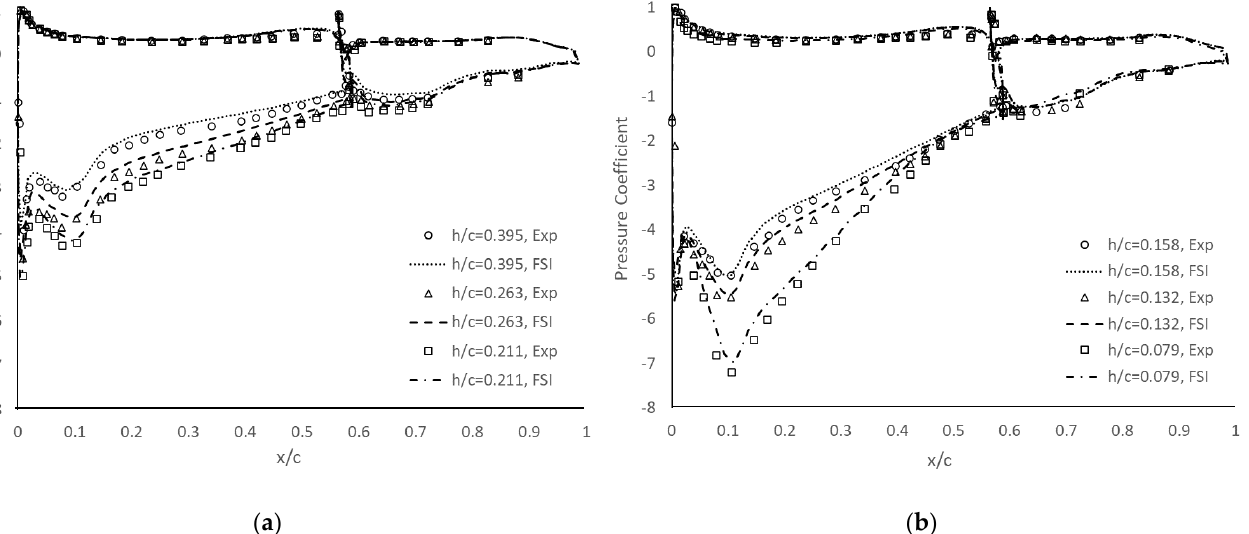
Figure 7. Chordwise surface pressure at wing centre and wing tip: ( a ) h/c = 0.395, ( b ) h/c = 0.105.